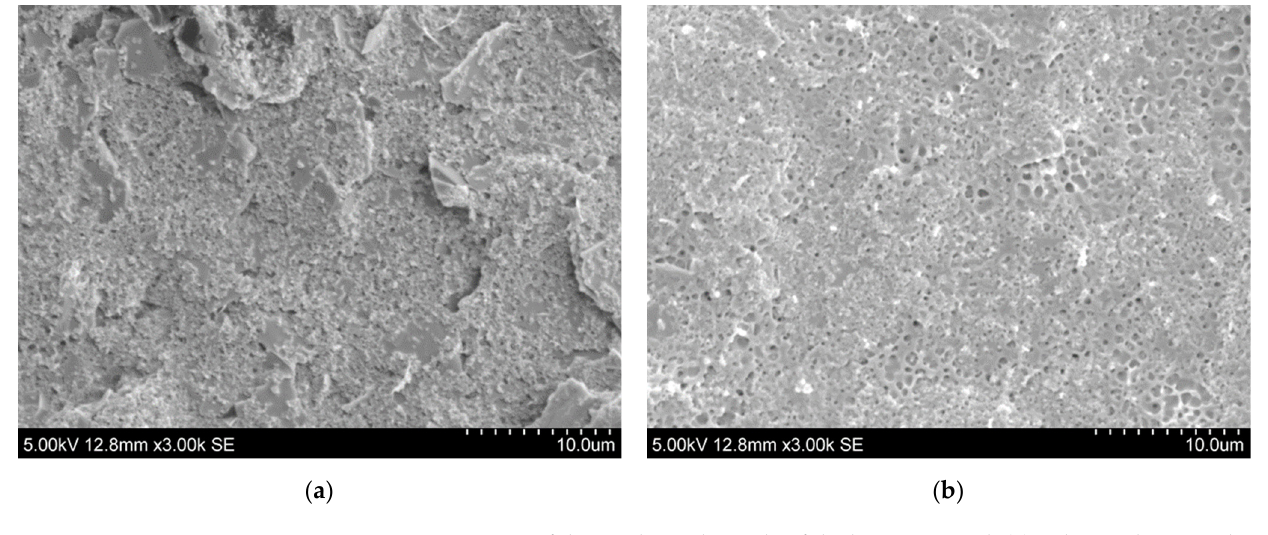
Figure 6. SEM images of the working electrode of the biosensor with ( a ) only graphene oxide and ( b ) full antibody functionalization. Notice the changes in the electrode’s morphology after full functionalization.